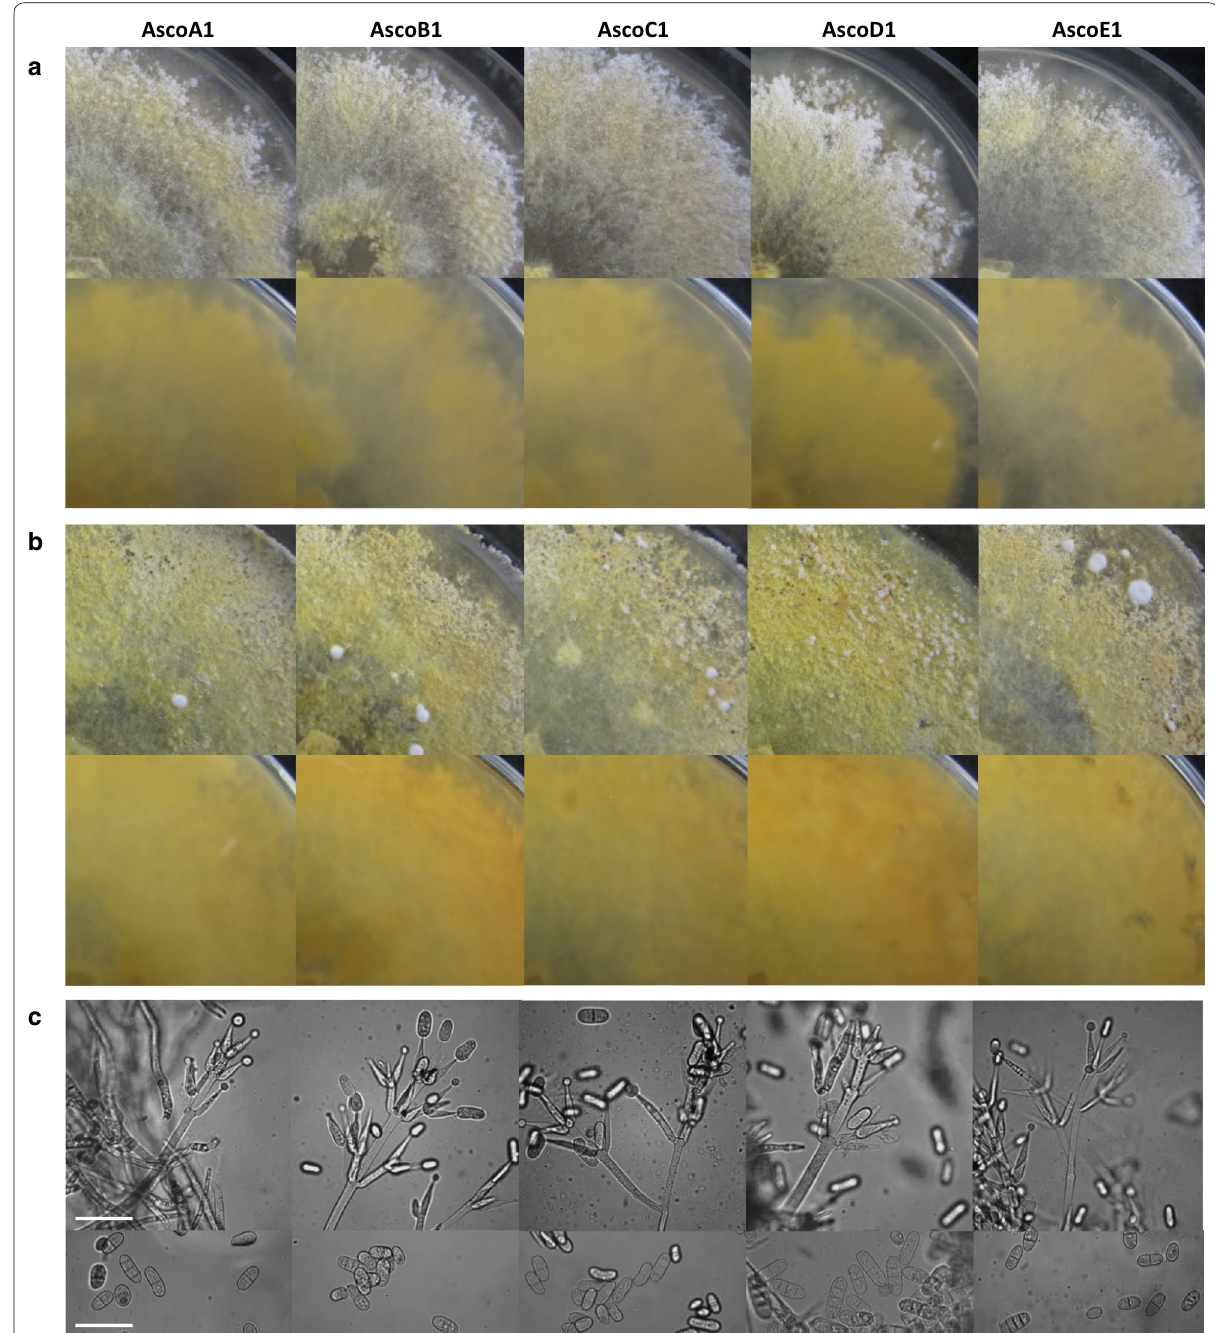
Fig. 4 Colony growth of five isolated conidiogenous strains on MEA at RT. a After 3–4 days of incubation with white fringed colony borders (upper row: plates from top, lower row: from reverse) and b with white pulvinate stroma in fully grown cultures after 25 days of incubation at RT (upper row: plates from top, lower row: from reverse). c Morphologies of conidiophores (top) and conidia (bottom) taken from aerial mycelium of growing cultures of isolated Hypomyces odoratus strains. Size bars: 50